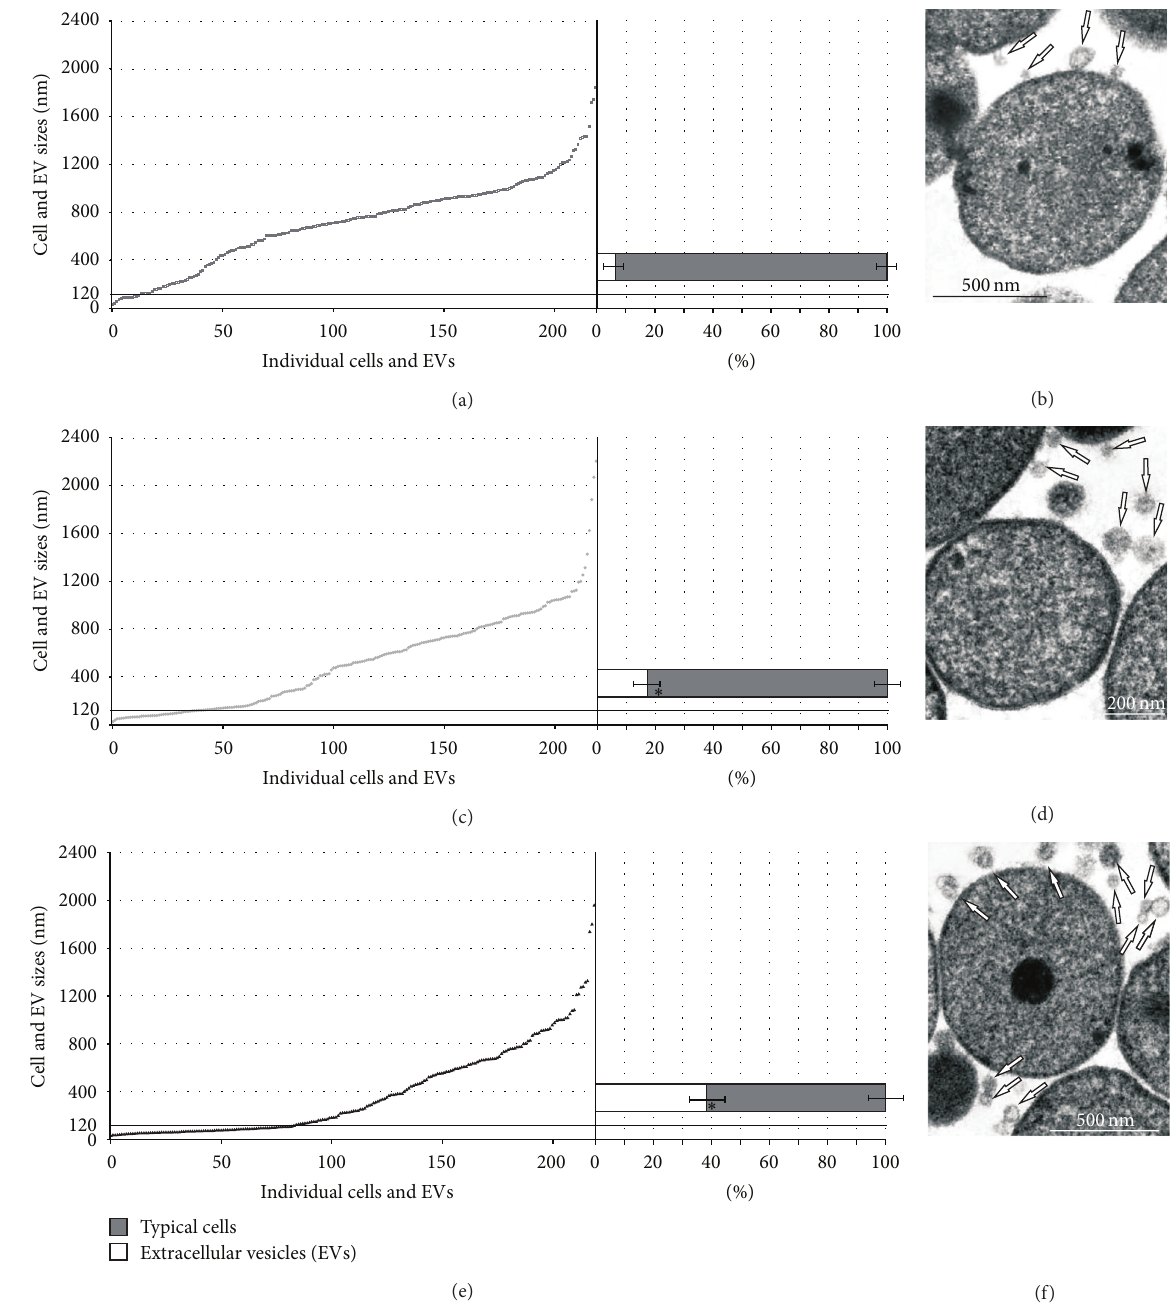
Figure 2: Relationships between typical cells and extracellular vesicles (EVs) (a, c, e) and transmission electron microscopy images (b, d, f) (extracellular vesicles (indicated by arrows)) of Acholeplasma laidlawii PG8 without ciprofloxacin (a, b), in the presence of antibiotic ∗∗ (c, d) and A. laidlawii PG8R (e, f) (according to transmission electron microscopy). Each point corresponds to the linear size of individual cells or EVs. ∗ 𝑃 < 0.05 . ∗∗ Treatment with ciprofloxacin for 80min.